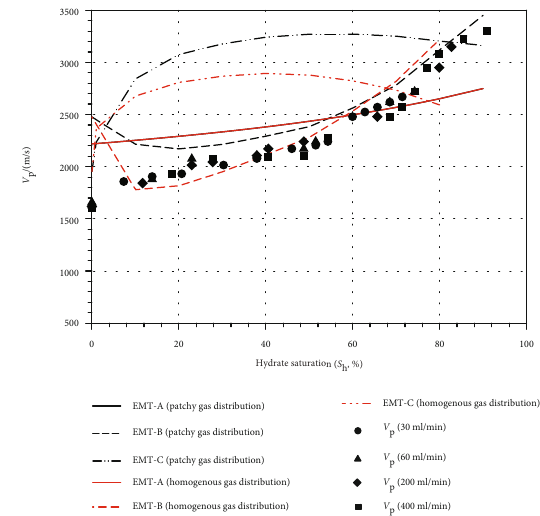
Figure 9: Variation of measured V and the calculated V from the p p EMT model with hydrate saturation (Data for Figure 9 are in Table S9 in the Supplementary Materials).